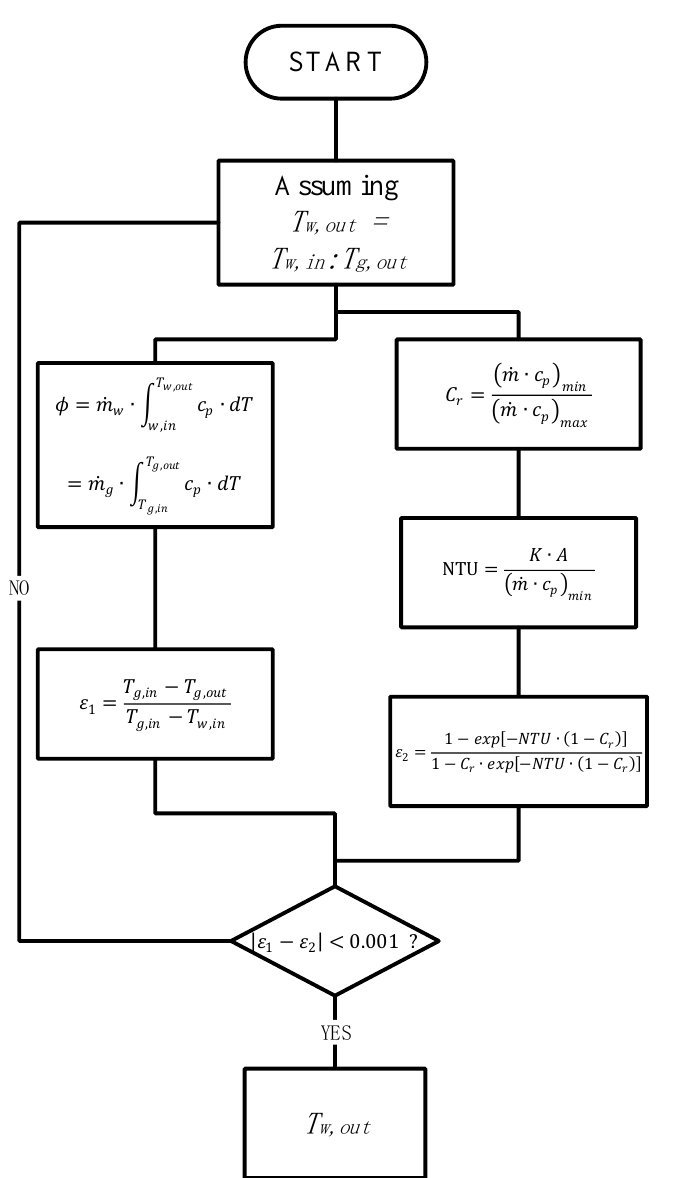
Figure 3. Flowchart of boundary verification.